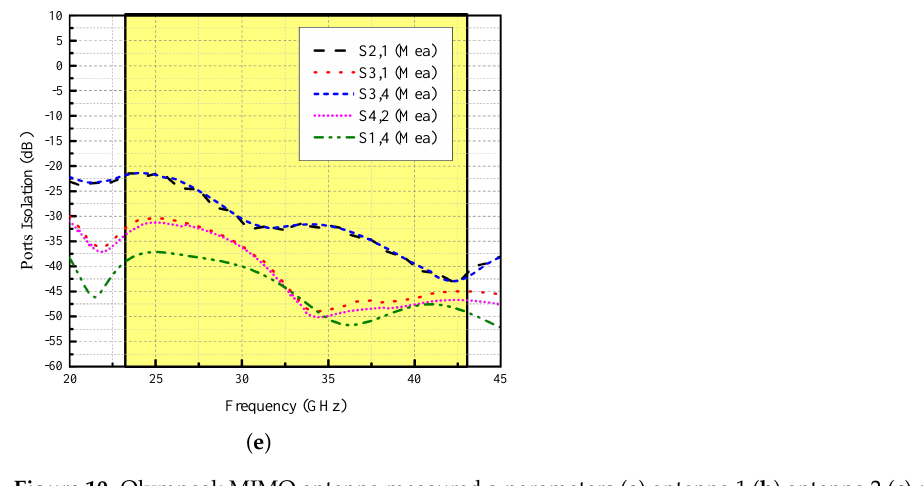
Figure 10. Olympeak MIMO antenna measured s-parameters ( a ) antenna 1 ( b ) antenna 2 ( c ) antenna 3 ( d ) antenna 4 ( e ) ports